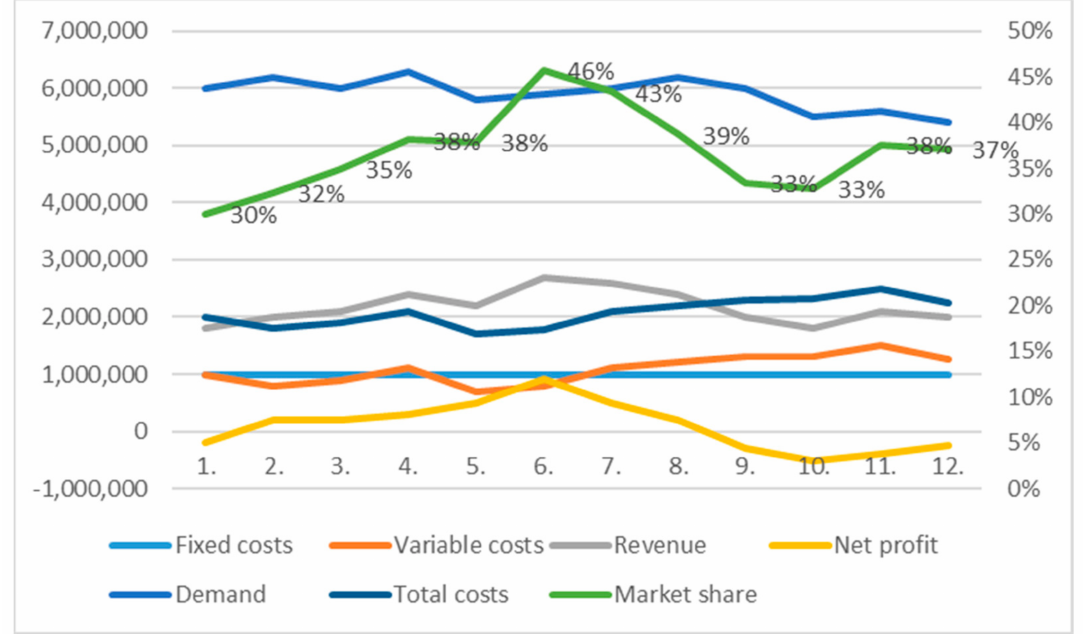
Figure 1. Key performance indicators of the economic evaluation of the company. Own study based on data of a company listed on the stock